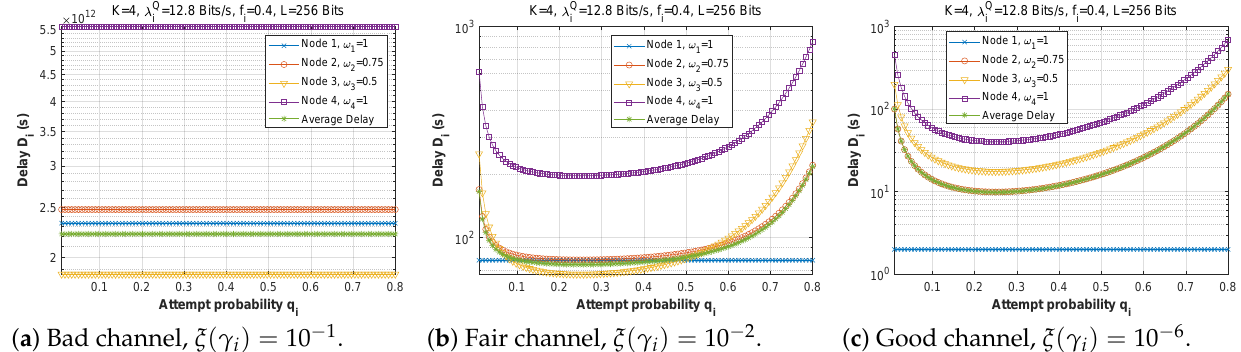
Figure 13. Setting 2: The delay experienced at each mobile device when varying the attempt probability with the bit error rate ξ ( γ i ) .